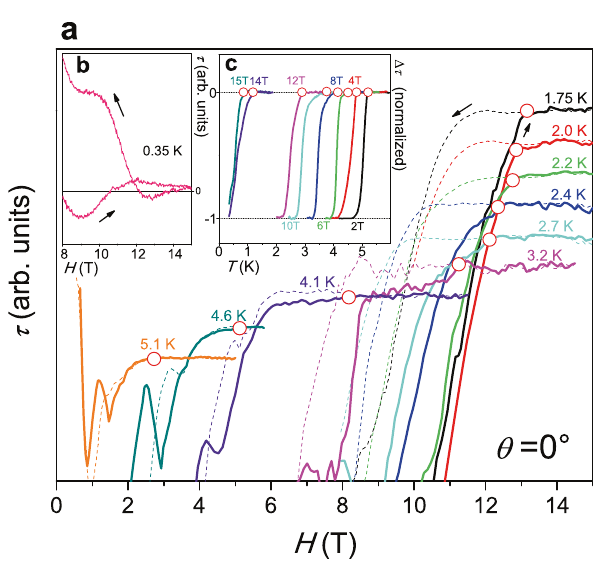
Fig. 2 Magnetic torque data in parallel fi elds of NbS 2 . a Magnetic torque magnitude τ ( H ) measured at fi xed temperatures as a function of the magnetic fi eld applied strictly parallel to the basal plane ( θ = 0°) near the onset upper critical fi eld H c2 (open circles). The solid lines represent data measured at increasing fi eld, while the dotted lines are data measured at decreasing fi eld (overlapping parts of the data for low fi elds have been omitted and offsets have been added for reasons of clarity). b Magnetic torque data at 0.35 K where H c2 exceeded the highest fi eld in our magnet cryostat. c Magnetic torque measured in fi xed parallel fi elds as a function of temperature. The data were normalized and a weak linear normal state background was removed for clarity. Open circles mark the onset critical temperatures.